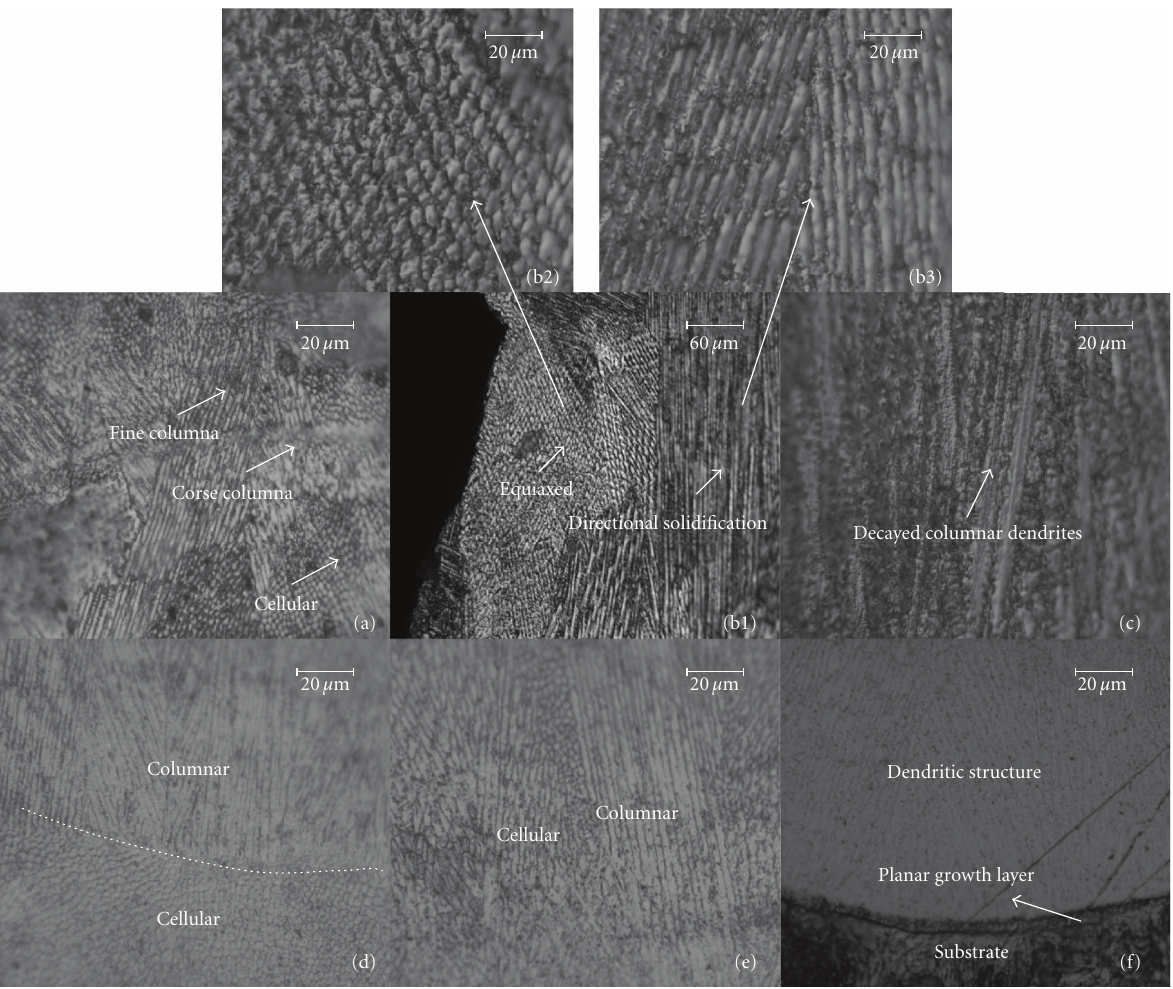
Figure 3: Transverse cross-section: (a)–(d) SS316L; (b)–(e) 50%SS316L+50%Inconel718; (c)–(f) Inconel718, (a)(b)(c)- FGM1, (d)(e)(f)-